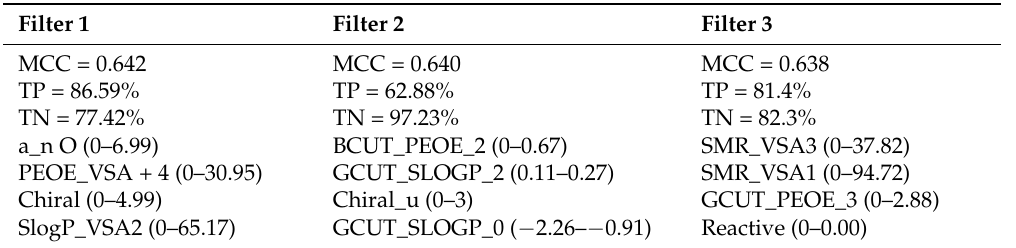
Table 1. Efficiency and descriptor ranges of three of the 47 filters used to produce the anti-diabetic activity indexing model.